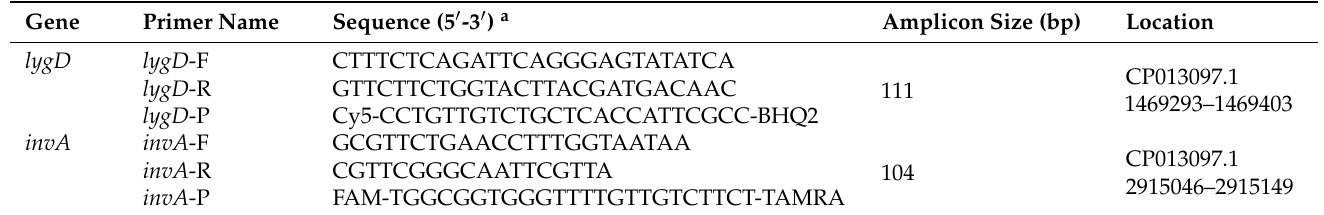
Table 2. Primers and TaqMan probes for the two genes used in the duplex real-time